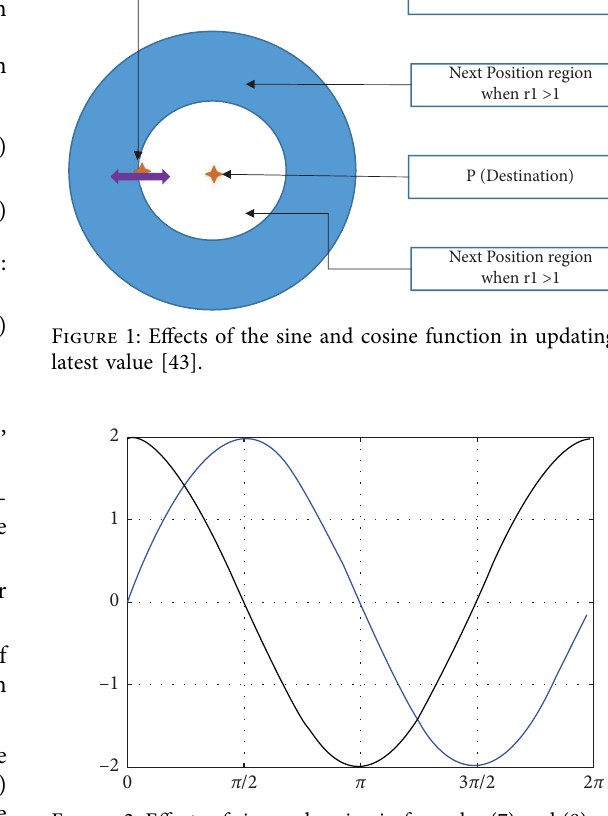
Figure 2: Efects of sine and cosine in formulas (7) and (8) on the next region and